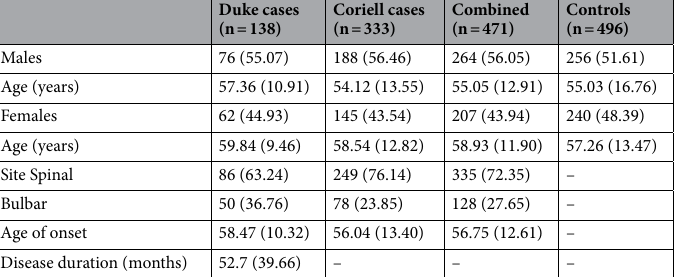
Table 1. Demographics of study participants used for case–control association study. Note: Displayed as numbers of participants (percentage) or means (standard deviations).